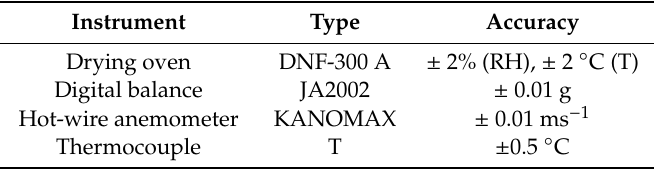
Table 2. Specifications of the instruments used in the lab experiment.